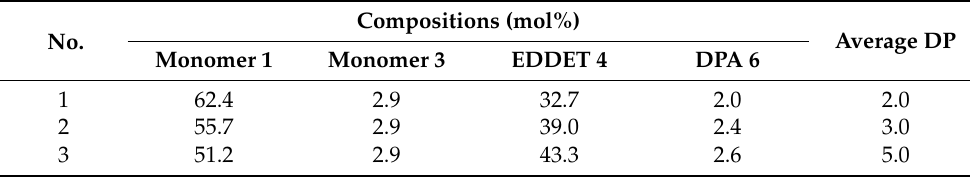
Table 1. Compositions of the oligomers with no monomer 2.